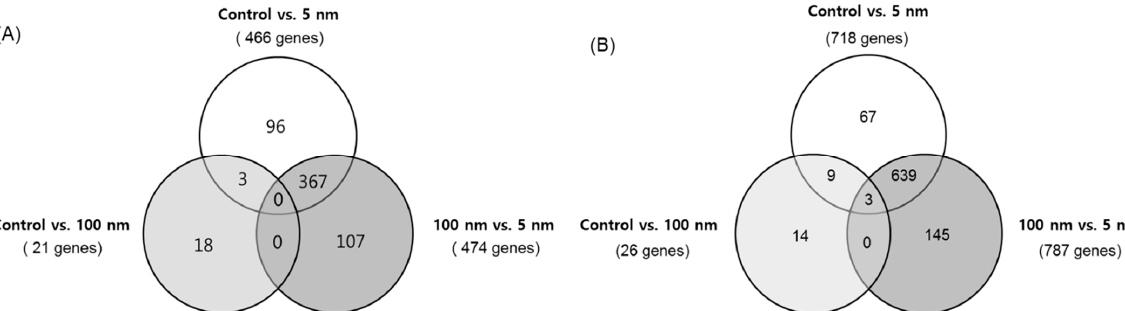
Figure 4. Hierarchical clustering. Microarray analysis of ( A ) untreated EA.hy926 cells vs. 5 nm NP-treated EA.hy926 cells, ( B ) 100 nm NP-treated EA.hy926 cells vs. 5 nm NP-treated EA.hy926 cells, ( C ) control vs. 5 nm NP-treated BEAS-2B cells, and ( D ) 100 nm NP-treated BEAS-2B cells vs. 5 nm NP-treated BEAS-2B cells is presented. Results were analyzed using a t-test, and significance was set at p < 0.05. 3.4. Classification of Genes That Showed Increased Expression Following Treatment with Silver NPs Genes that showed increased gene counts in EA.hy926 and BEAS-2B cells were divided into five categories based on the following gene ontology (GO) terms: cell death, cell survival, inflammation, apoptosis, and reactive oxygen species (ROS). IL-11 was included in the cell survival and inflammation categories. The results (Supplementary Tables S1–S10) suggested that 5 nm silver NPs activated inflammation and ROS stimulated expression of cell proliferation-related genes. Most of the stress-related genes were included in the cell death, apoptosis, and ROS categories. 3.5. Effects of Silver NPs on Cytokine Production and Inflammatory Response Cells were treated with silver NPs at different concentrations for 8 h (Figure 5A,B) and 24 h (Figure 5C,D). IL-8 and IL-11 were expressed at 1000 pg/mL or more in EA.hy926 cells treated with 5 nm silver NPs at 2.5 µg/mL. IL-8 production was found to be the highest at 1413 pg/mL in cells treated with silver NPs at 0.5 µg/mL. IL-11 production was